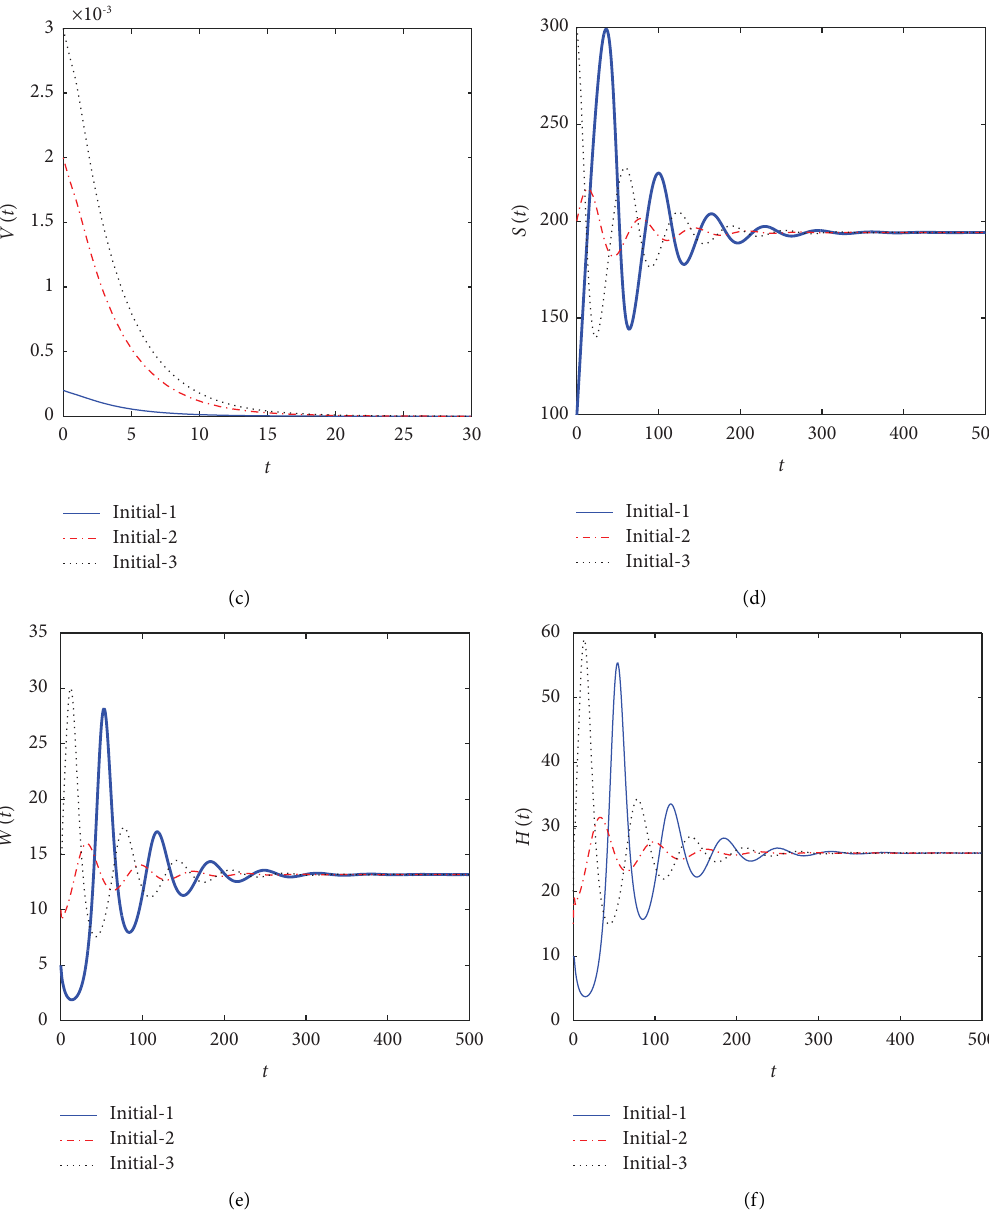
Figure 3: Te numerical simulations of model (64) for η � 0 . 0006, υ � 0 . 01, ℘ � 0 . 3, and I � 0 . 0016 using three diferent initial conditions sets. HIV-1 monoinfection equilibrium EP H � ( 22 . 41 , 0 , 0 , 186 . 478 , 13 . 3211 , 27 . 266 ) is G.A.S. (a) Uninfected epithelial cells. (b) Infected epithelial cells. (c) SARS-CoV-2. (d) Uninfected CD4 + T cells. (e) Infected CD4 + T cells. (f)